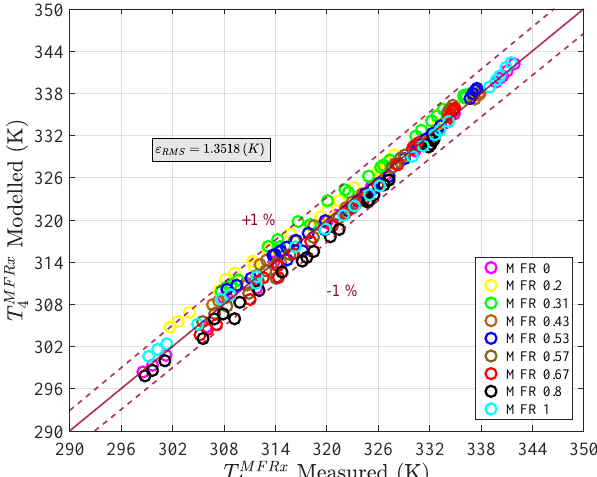
Figure 23. Comparing the prediction of modeled mixed turbine outlet temperature with experimental values for T#1TE